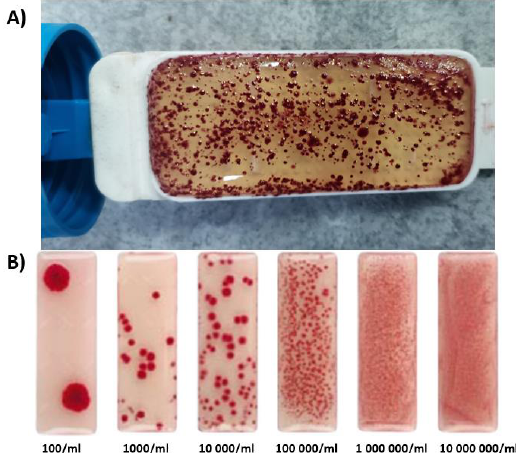
Figure 2. ( A ) Appearance of the test obtained after immersion of the insert in the active sludge (the number of bacteria per 1 mL of active sludge after a 96-h observation). ( B ) Appearance of the reference test.